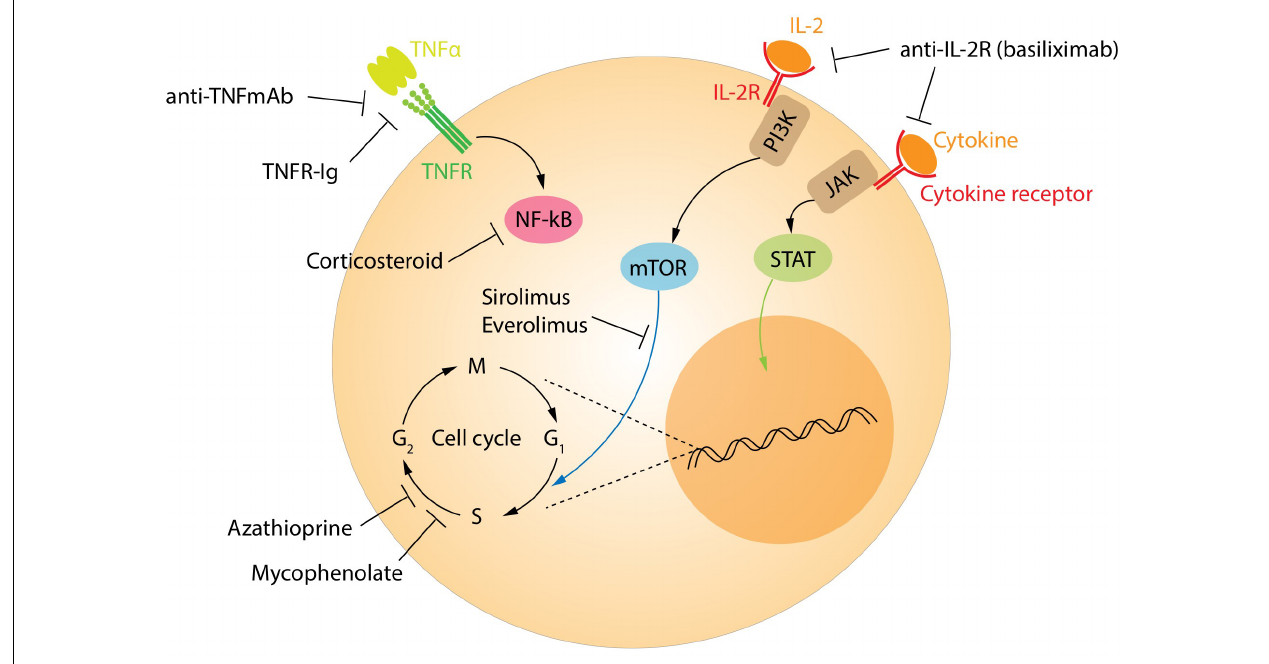
FIGURE 5 | Treatment targets of immunosuppression. The main targets of the immunosuppressive drugs.